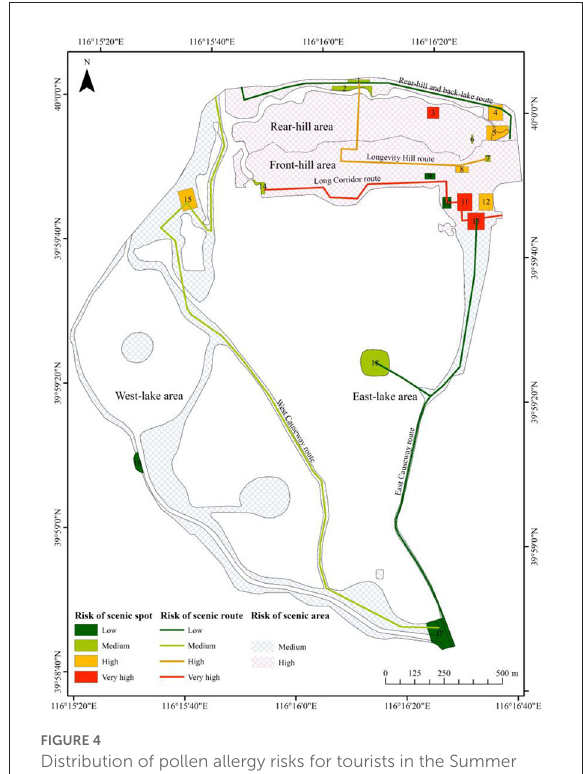
FIGURE4 Distribution of pollen allergy risks for tourists in the Summer